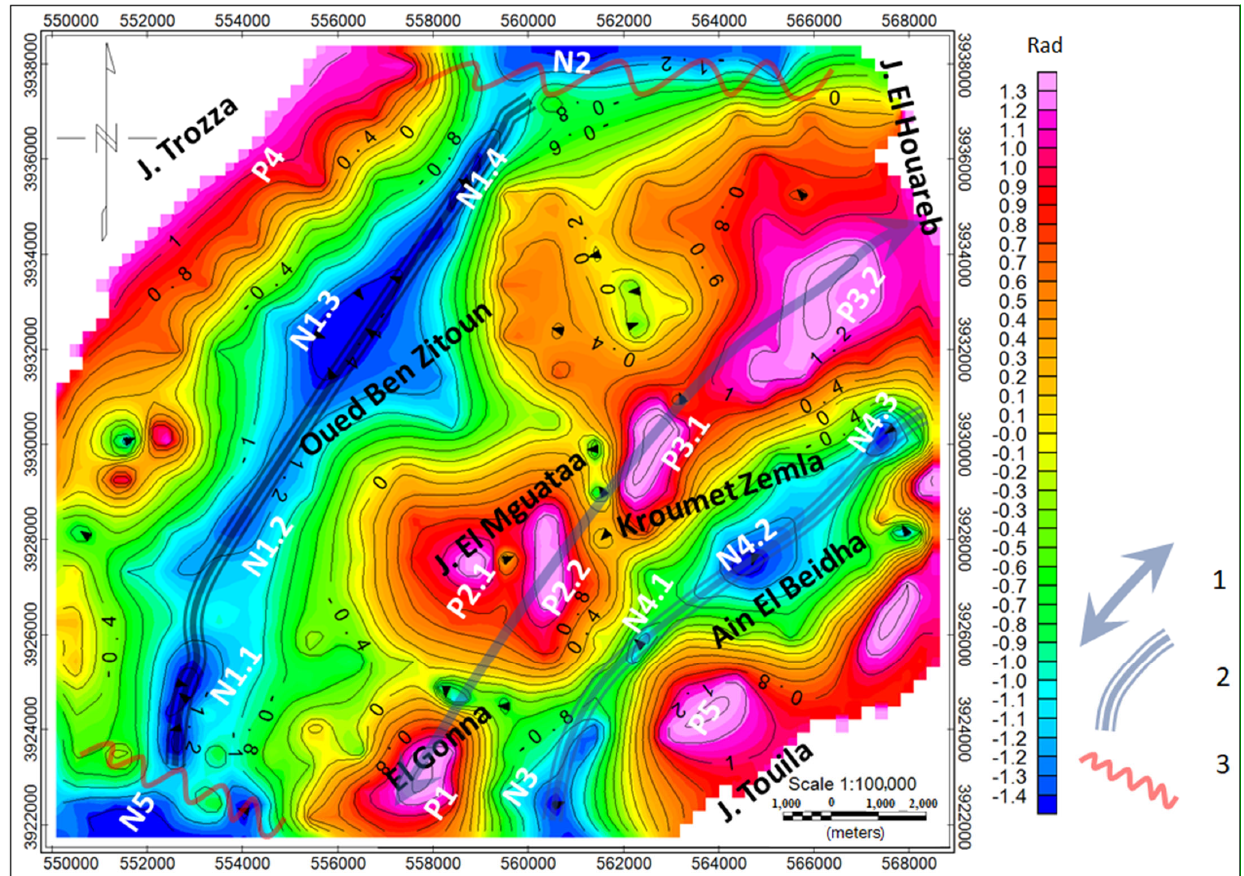
Figure 6. Interpreted tilt angle map of the Ain El Beidha plain. (1) Major positive gravity anomaly axis. (2) Major negative gravity anomaly axis. (3) Northern and southern limits of the Ain El Beidha plain.